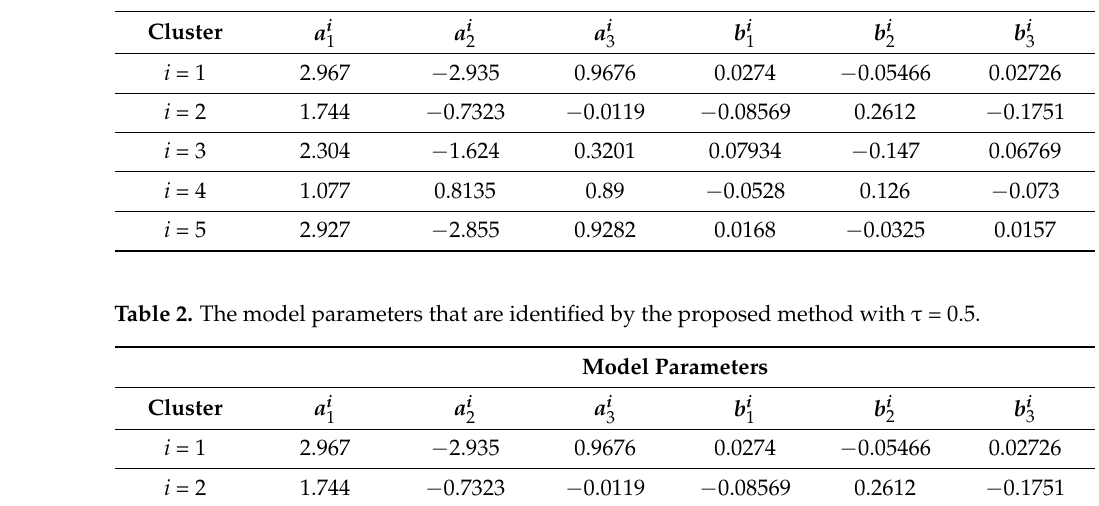
Table 2. The model parameters that are identified by the proposed method with τ = 0.5.